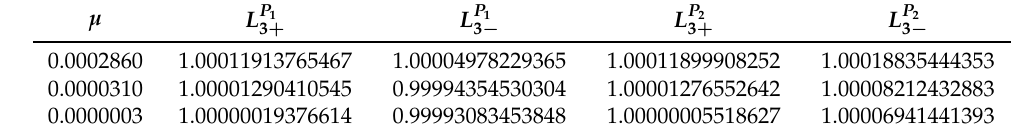
Table 6. Equilibrium solution near L 3 of different planetary systems.